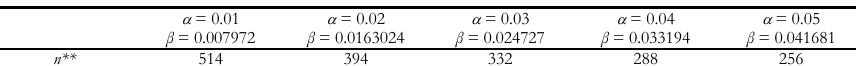
The optimum value of n* for fixed sample size test procedure for testing H 0 : p = p 0 = 0.6 against